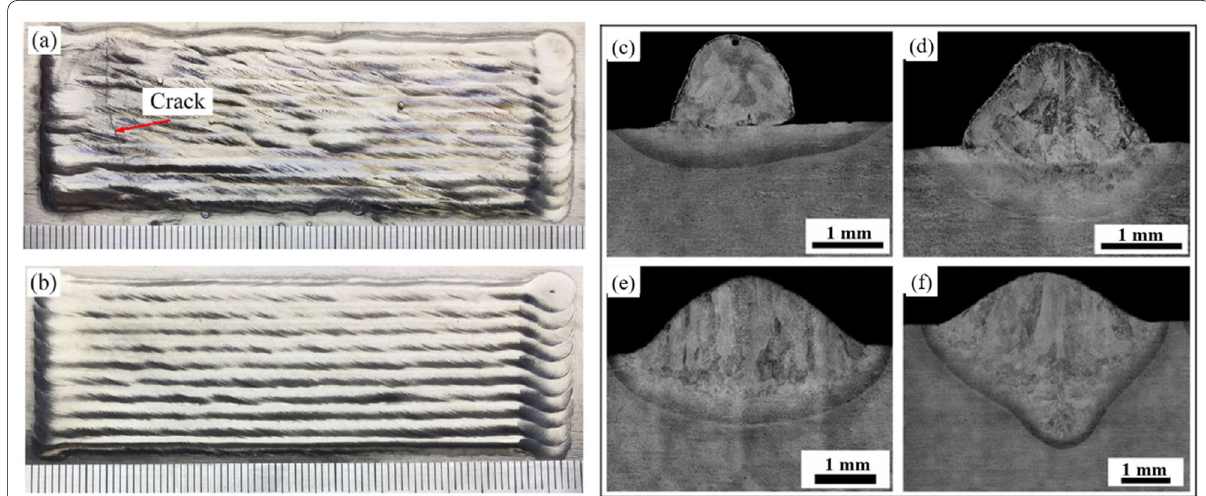
Figure 13 Wire-based laser cladding layers of Ti-6Al-4V in ( a ) underwater and ( b ) in-air environment [41]; Cross sections of the single track Ti-6Al-4V deposited in underwater and in air environments: ( c ) 10 L/min, ( d ) 18 L/min, ( e ) 20 L/min, ( f ) in-air environment